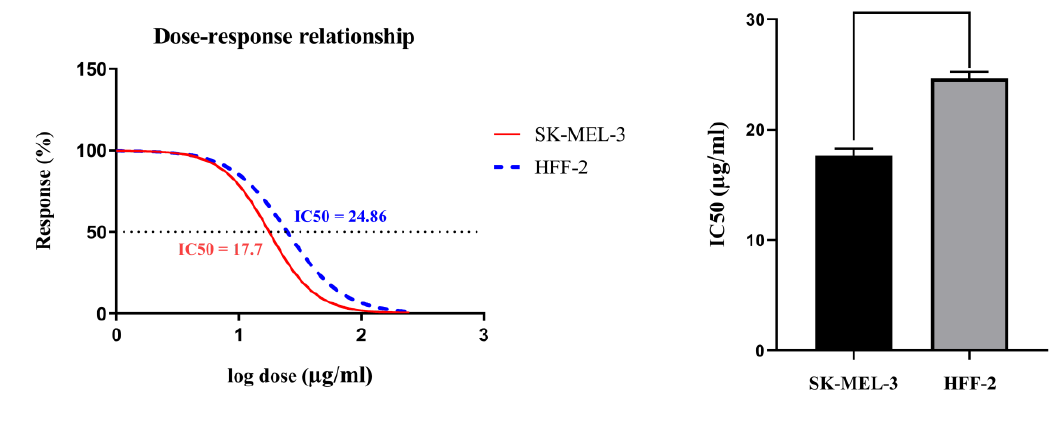
Figure 3. The viability curves of the cell dose–response of recombinant cytotoxin-II in HFF-2 and SK-MEL-3 cell lines. The cells were treated with different concentrations of recombinant cytotoxin-II for 24 h, and at the end of the incubation time, cell viability was determined by the MTT (3-(4,5-dimethylthiazol-2-yl)-2,5-diphenyltetrazolium bromide) reduction assay. The SK-MEL-3 cell line (Red) and HFF2 cell line (Blue). Error bars display the ± SD. The independent t -tests assessed the p -values. p < 0.0001 (****).